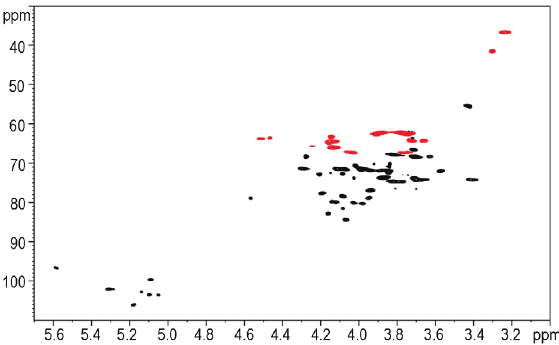
Figure 8 - 1 H- 13 C HSQC spectrum of the PI-oligosaccharide isolated of GIPLs from epimastigotes of T. cruzi strain Silvio X10/1 (CH black, CH 2